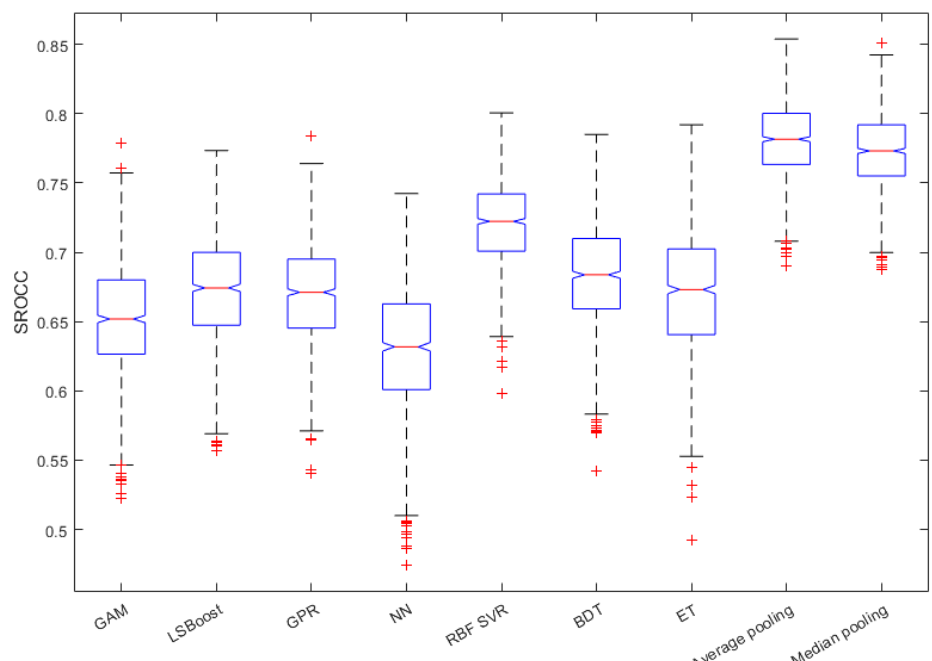
Figure 6. Box plots of SROCC values for different regression techniques and strategies. Measured over 1000 random training–testing splits on KoNViD-1k [16]. The bottom and top edges of each box correspond to the 25th and 75th percentiles, respectively. The whiskers continue to the most extreme data points that were not recognized as outliers, which are denoted by red ‘+’ symbols.